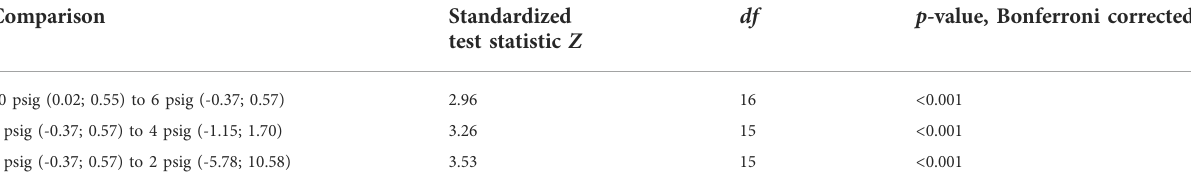
TABLE 2 Wilcoxon sign test of minimum mask pressure for different regulator inlet pressures.